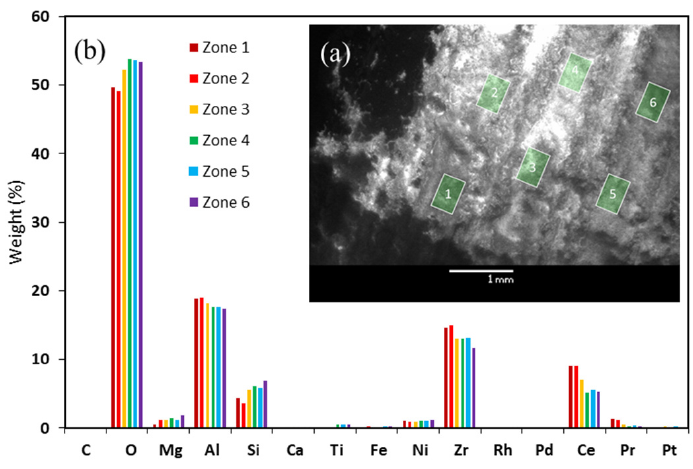
Figure 5. ( a ) SEM image of RM; ( b ) elemental composition obtained by EDS of the zones indicated in ( a ).